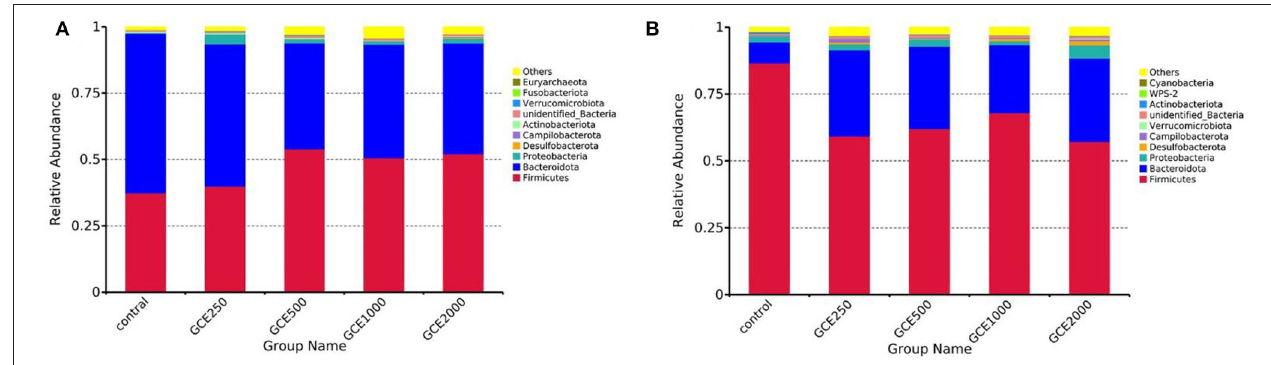
FIGURE 1 | Phylum-level taxonomic composition of the cecal bacterial communities in different groups: (A) 28 days; (B) 60 days.